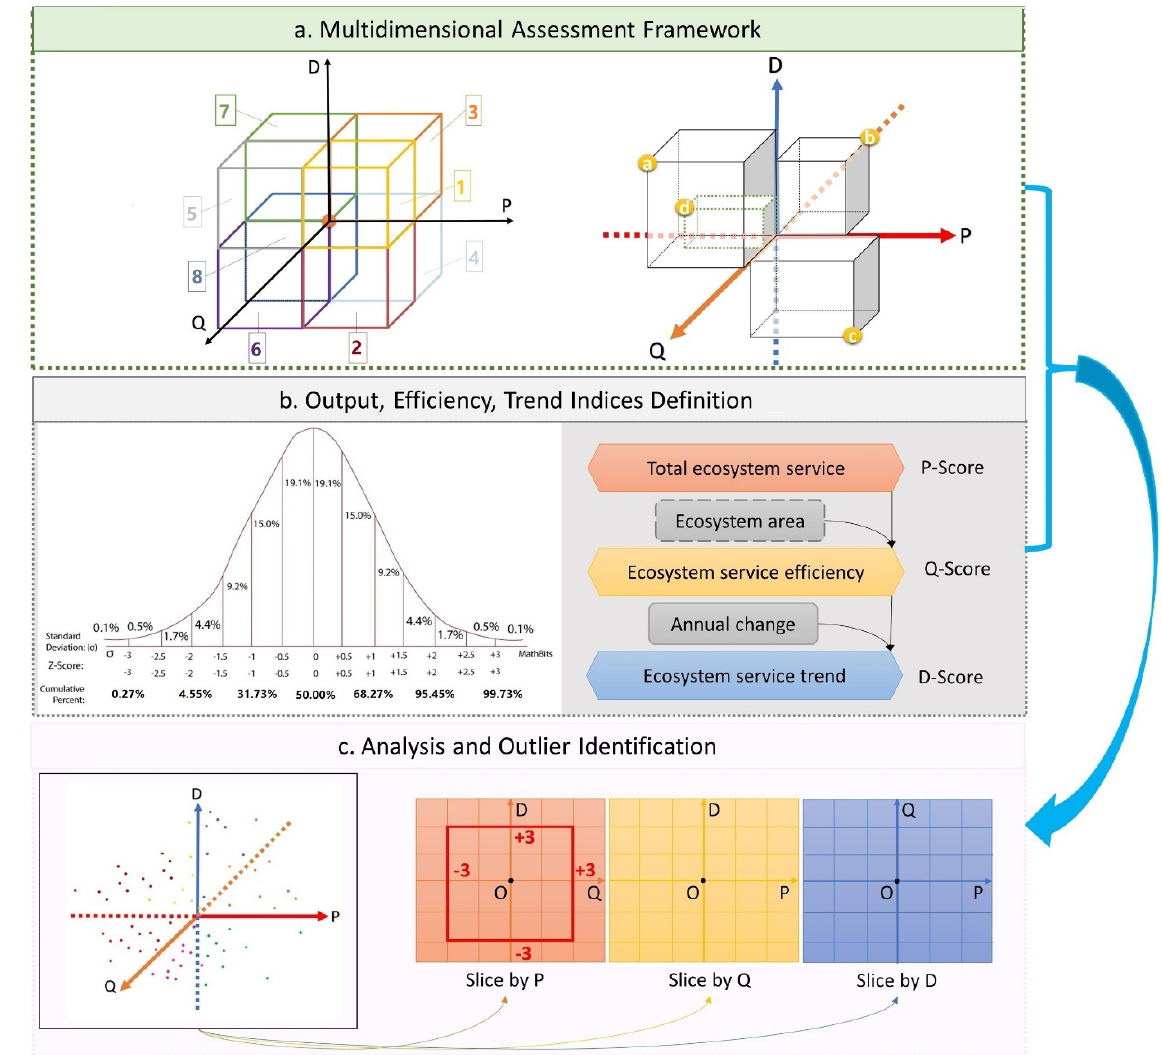
Figure 8. The multidimensional framework for evaluating ecosystem services.